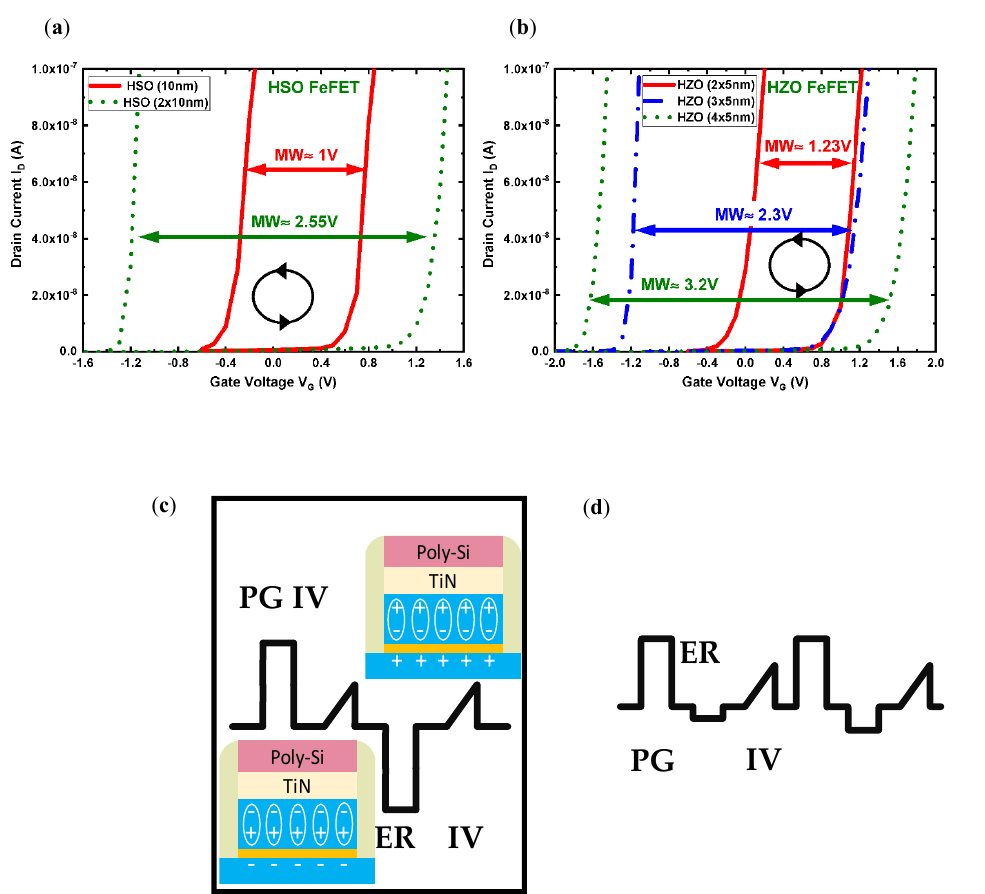
Figure 7. The laminate FeFET counterclockwise I D –V G switching characteristics illustrated as a comparison for the different stack flavors of ( a ) HSO and ( b ) HZO material, electrical measurement sequence for ( c ) the MW switching, ( d ) the ER amplitude dependence of ferroelectric switching. Reproduced with permission from [17] T. Ali et al., IEDM; published by IEEE, Copyright 2019, IEEE.